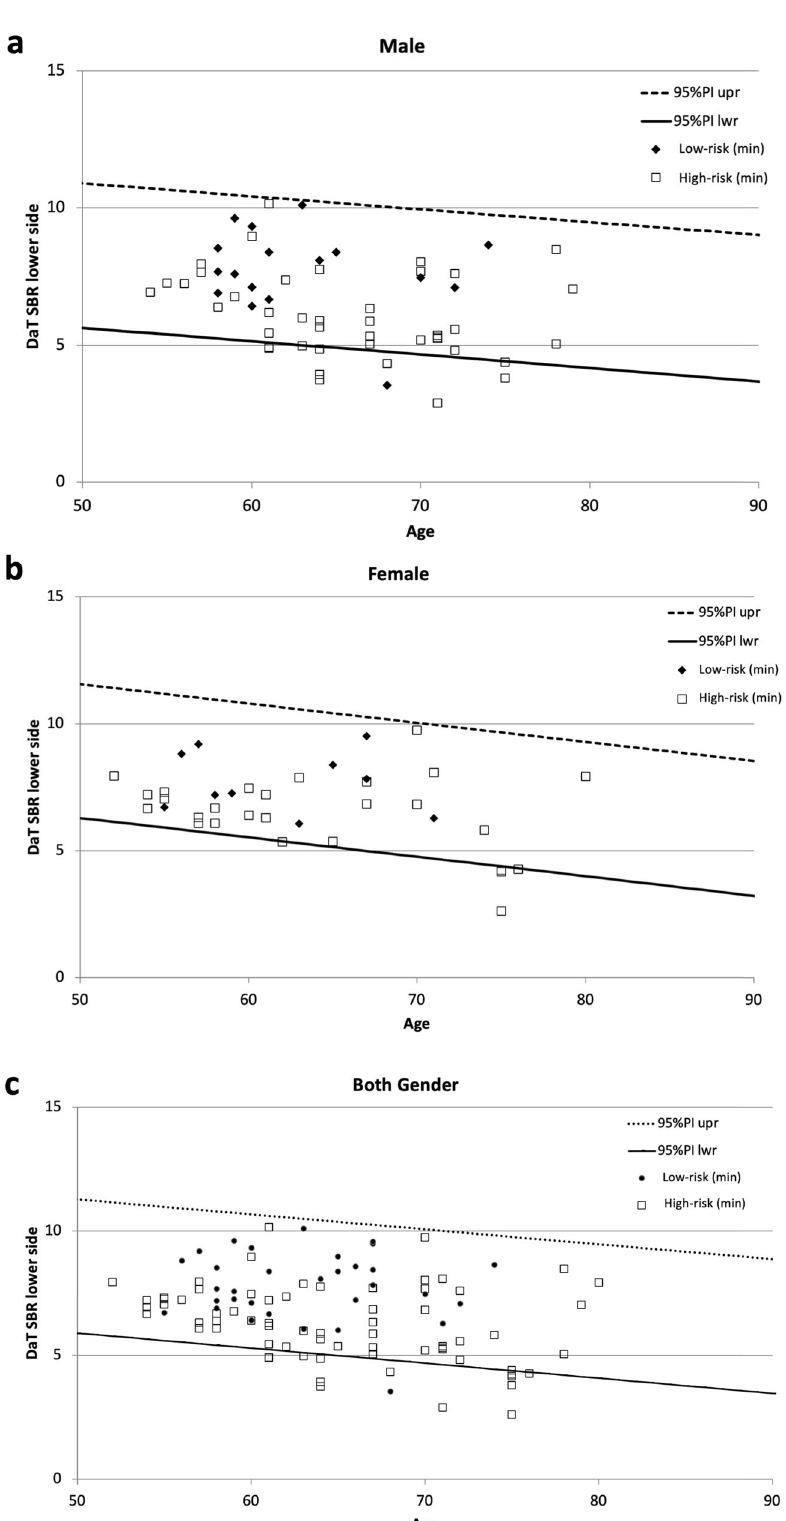
Fig. 2 Scatterplot of SBR by age for the high-risk and low-risk subjects. SBR values of DaT-SPECT of the high-risk and low-risk subjects were plotted with lines showing the upper and lower limits of the 95% con fi dence interval in healthy subjects 27 . a males; b females; c both genders. DaT dopamine transporter, SBR speci fi c binding